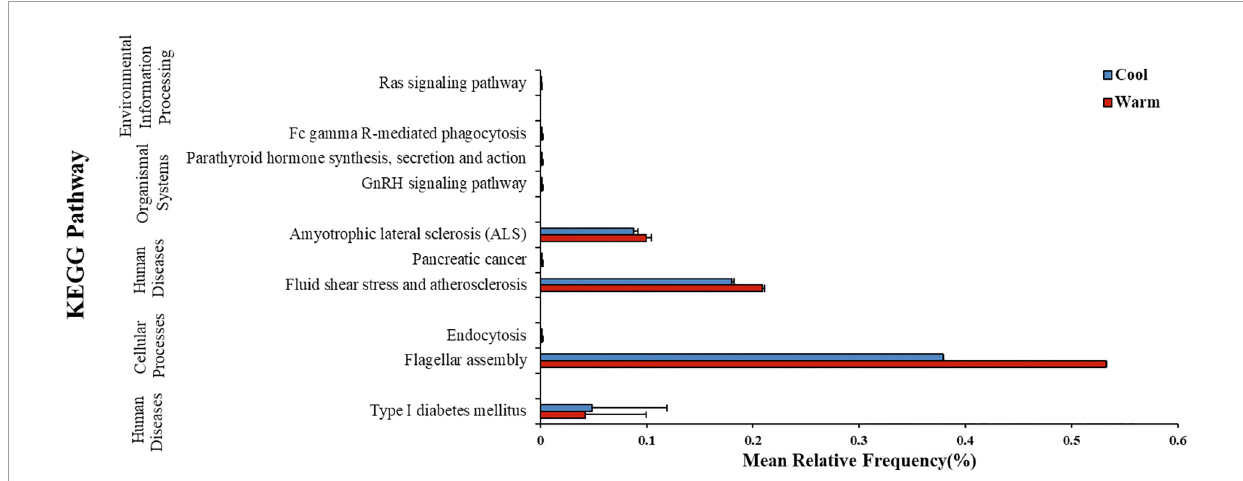
FIGURE3 Mean ± SD relative frequency (%) of KEGG pathways that differed in relative frequency across two temperature treatment groups after 168 h (7 days) of exposure to the temperature treatment in common carp gut bacterial communities. KEGG pathways were identified from predicted metagenomic profiles created using the PICRUSt2 program and significance by temperature groups was determined using a Welch’s two-sample t -test, with FDR corrected p